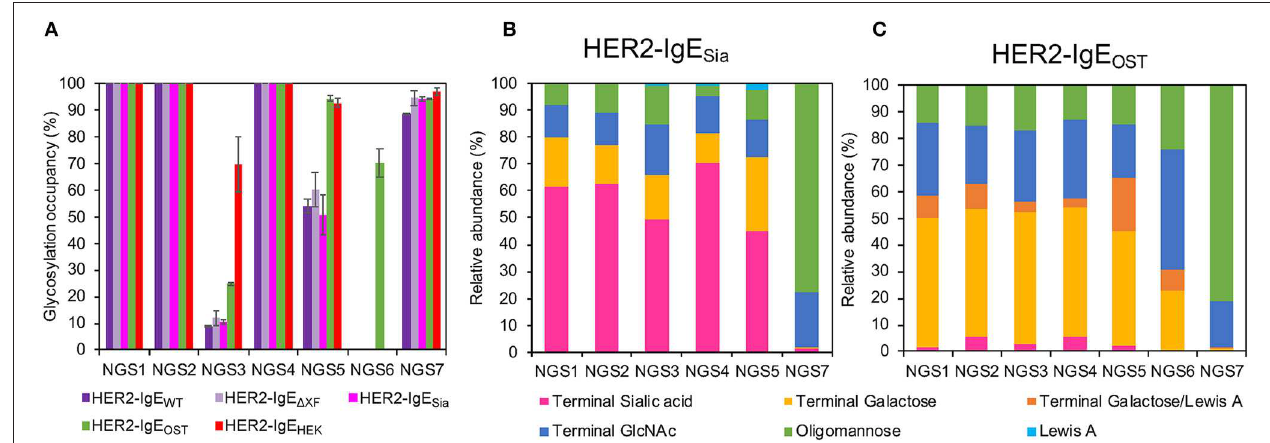
FIGURE 2 | Analysis of the glycosylation status of HER2-IgE. (A) N -glycosylation site (NGS)-specific occupancy (%). Analysis of NGS1-7 of HER2-IgE expressed in Nicotiana benthamiana wild type plants (HER2-IgE WT ), glycosylation mutants 1 XTFT (HER2-IgE 1 XF ), 1 XTFT Sia (HER2-IgE Sia ), co-expressed with L. major STT3D oligosaccharyltransferase (OST) in any N. benthamiana line (HER2-IgE OST ), and expressed in human Expi293F cells (HER2-IgE HEK ). The ratio of deamidated to unmodified peptide was calculated for each NGS following N-glycan release with PNGase A treatment. N = 2, error bars show the standard deviation. See Supplementary Table 2 for details. (B) Relative abundance (%) of glycoforms present in each occupied NGS of HER2-IgE Sia . For detailed information, see Supplementary Table 7 . (C) Relative abundance (%) of glycoforms present in each occupied NGS of HER2-IgE OST . For detailed information, see Supplementary Table 8